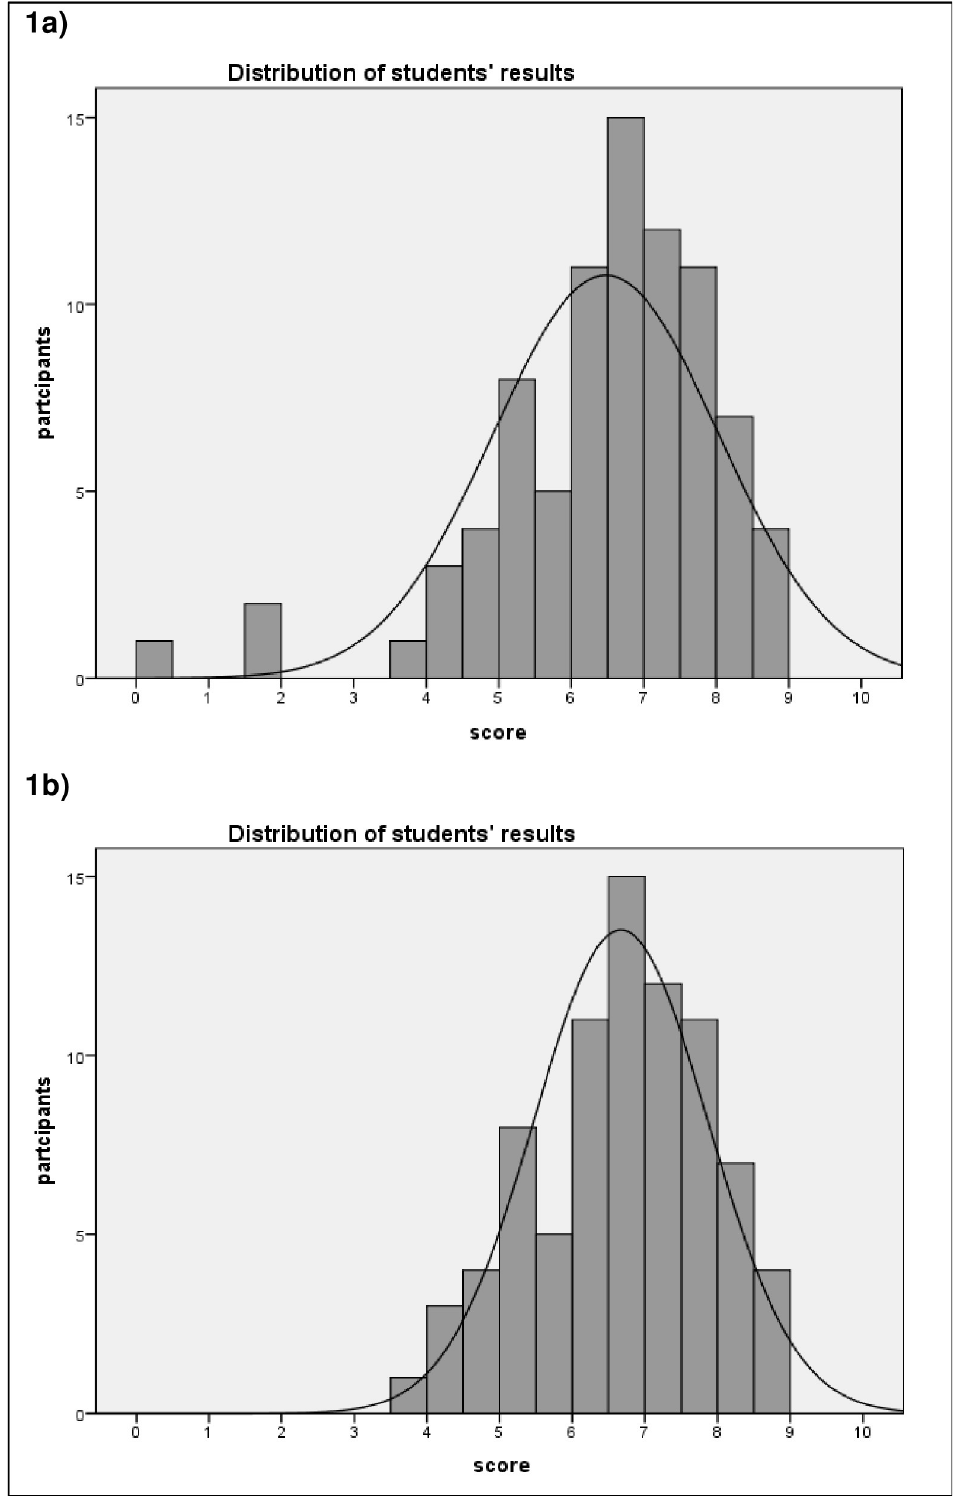
Fig 1. Statistical analysis of the KFPE. 1a) Students’ KFPE results, n = 84; average score: 6.47 points, SD = 1.56 1b) Students’ KFPE results after exclusion of the 3 outliers, n = 81; average score: 6.67 points, SD = 1.20.